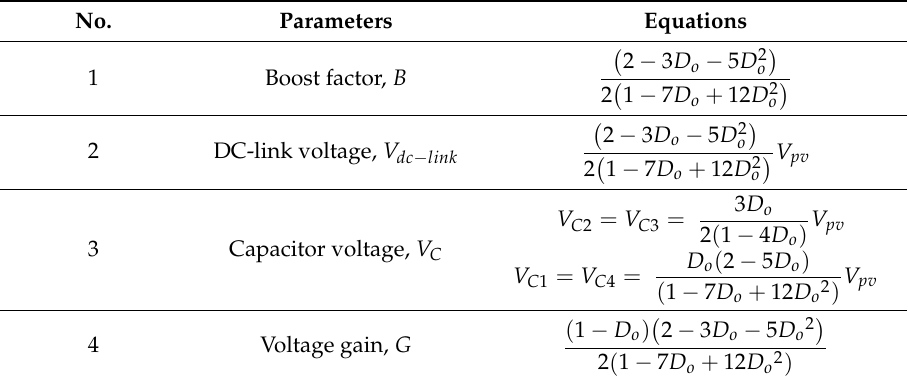
Table 1. Governing equations of